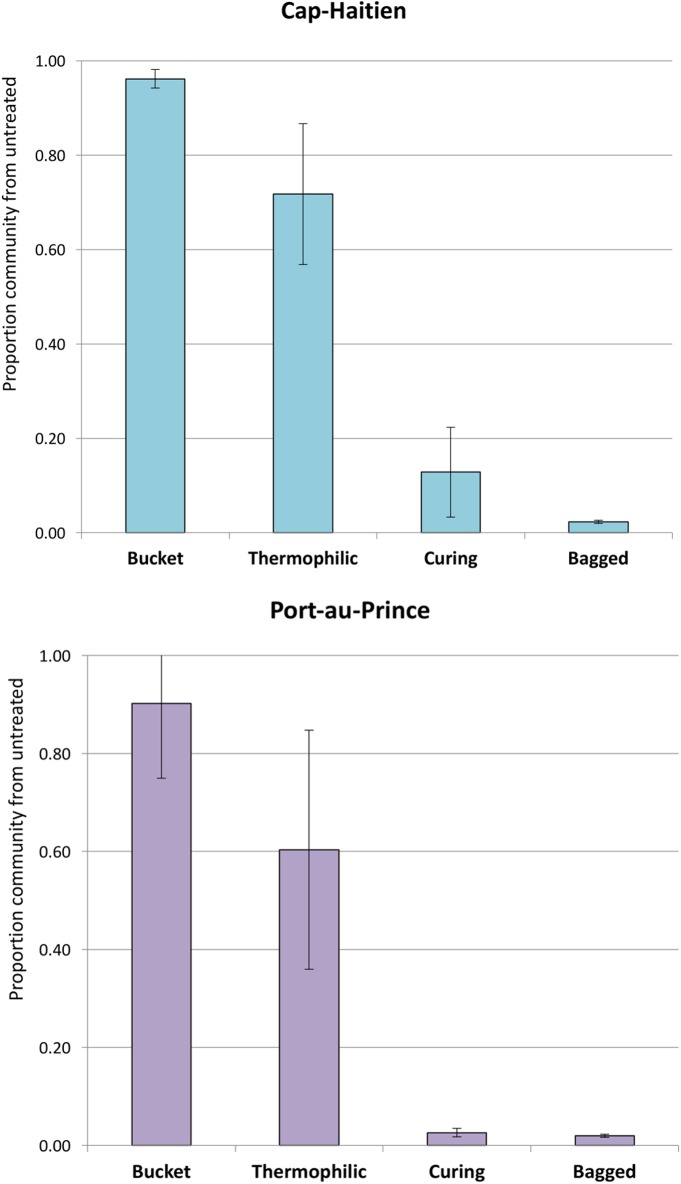
Proportion of microbial community derived from untreated source material (Bucket) samples throughout the composting process.Proportions were estimated by SourceTracker using binary OTU data from individual Bucket samples as the training (source) set and Thermophilic, Curing and Bagged samples as sinks. Source proportions in each Bucket sample were estimated using the leave-one-out validation procedure and averaged. Error bars are standard deviations around the mean.